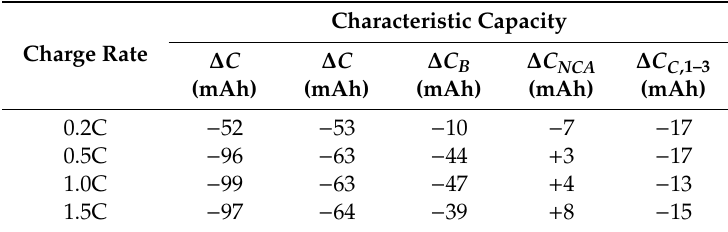
Table A1. Change of characteristic capacities after load cycle 1 at 0 ◦ C.